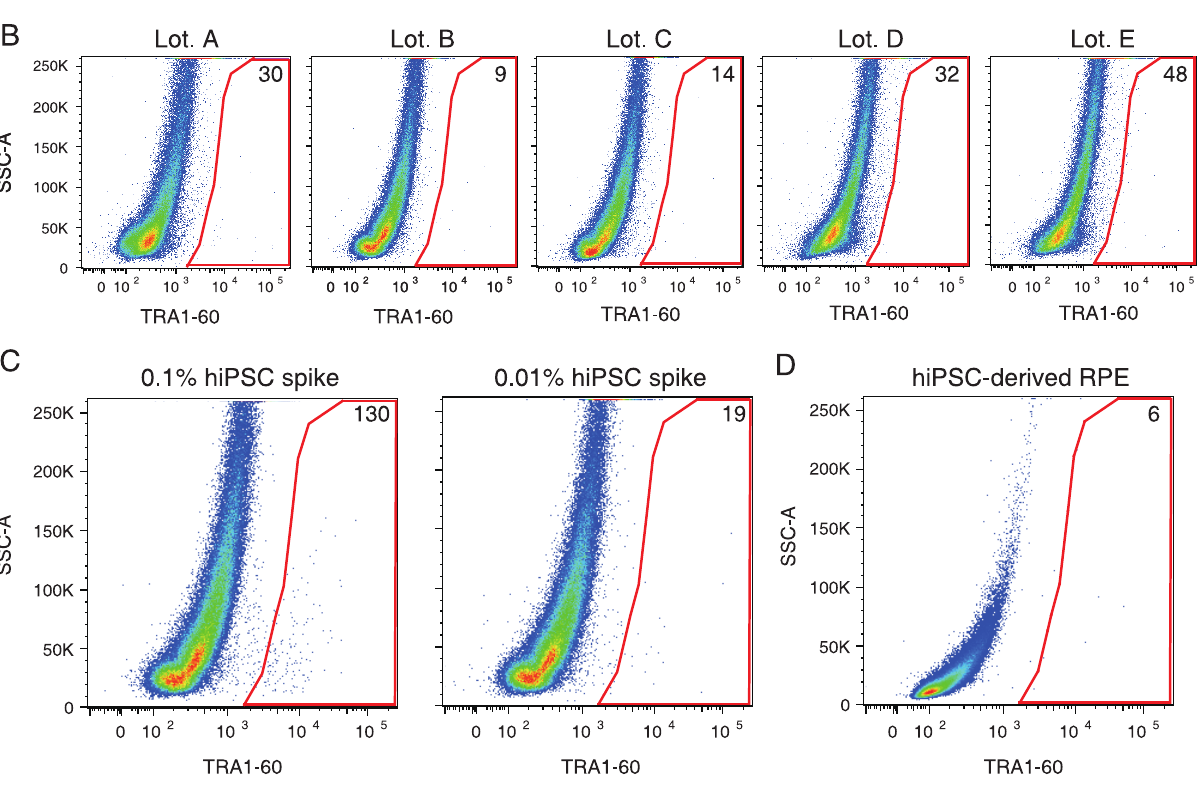
Figure 3. Detection of undifferentiated hiPSCs by flow cytometry assay. (A) Flow cytometry analysis of hiPSCs (blue) and primary RPE cells (red). Cells were fixed, permiabilized and stained with anti-TRA-1-60, anti-TRA-1-81, anti-Sox2, anti-Oct3/4 and anti-Nanog antibodies labeled with fluorophore. (B) Five lots of primary RPE cells were analyzed by flow cytometry with anti-TRA-1-60 antibody. (C) HiPSCs (0.1%, 2.5 6 10 2 cells; 0.01%, 25 cells) were spiked into primary RPE cells (2.5 6 10 5 cells) and analyzed by flow cytometry with anti-TRA-1-60 antibody. (D) Flow cytometry analysis of hiPSC-derived RPE cells was performed with anti-TRA-1-60 antibody. Ten thousand cells (A) and 1 6 10 5 cells (B–D) were used for one assay of flow cytometry analysis. The numbers indicate the quantity of cells contained in the gate. doi:10.1371/journal.pone.0037342.g003 PLoS ONE | www.plosone.org 6 May 2012 | Volume 7 | Issue 5 |